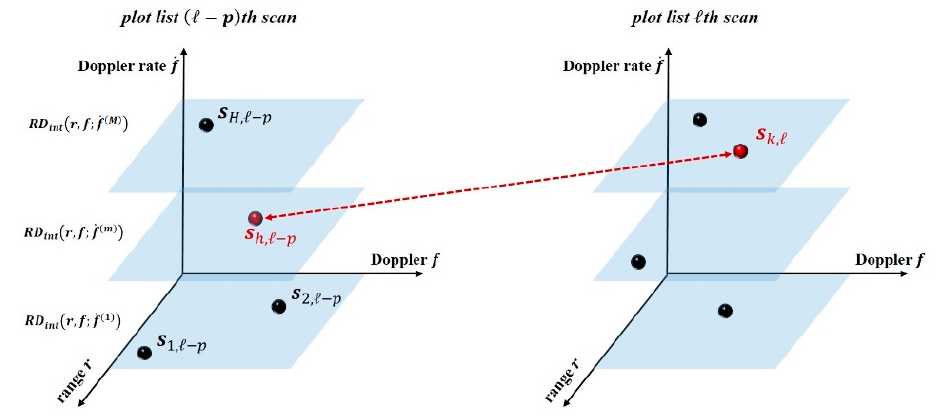
Figure 5. Correlations of plots belonging to successive plot lists.